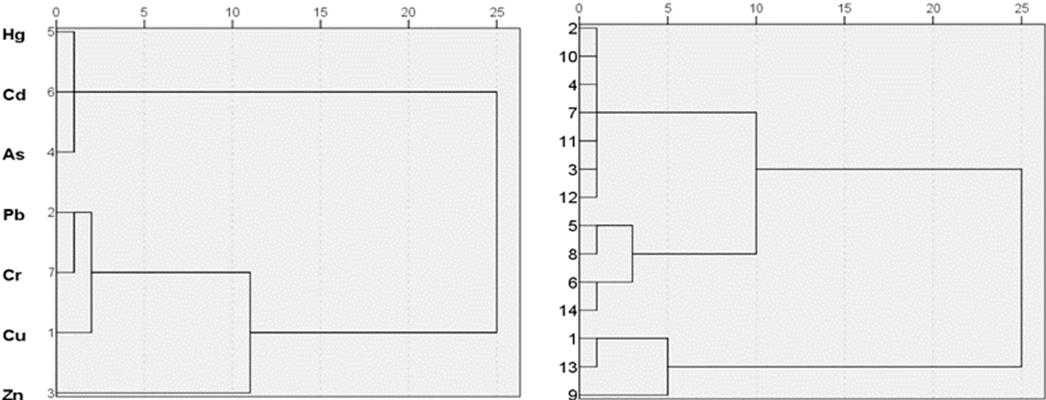
Figure 5. Cluster analysis results in 2012.